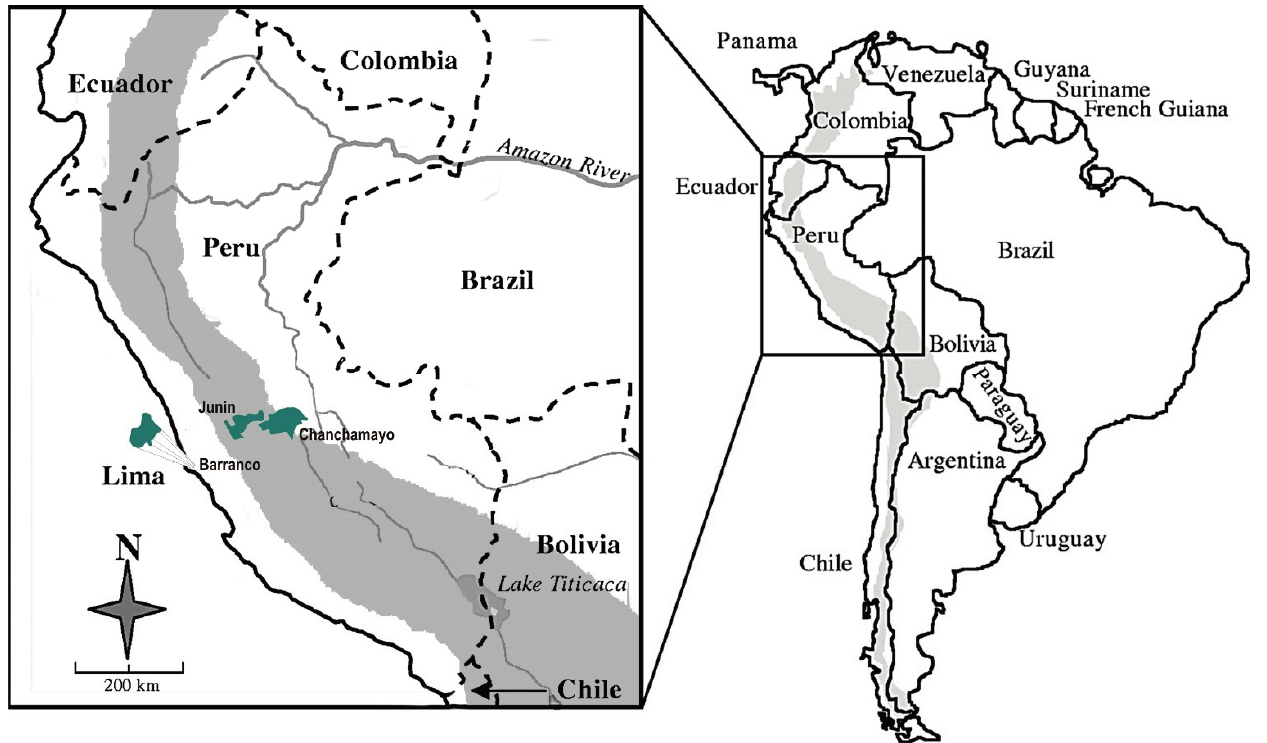
Figure 1. South America and representation of the region of the Andes. Location of the Peruvian cities indicated in the present